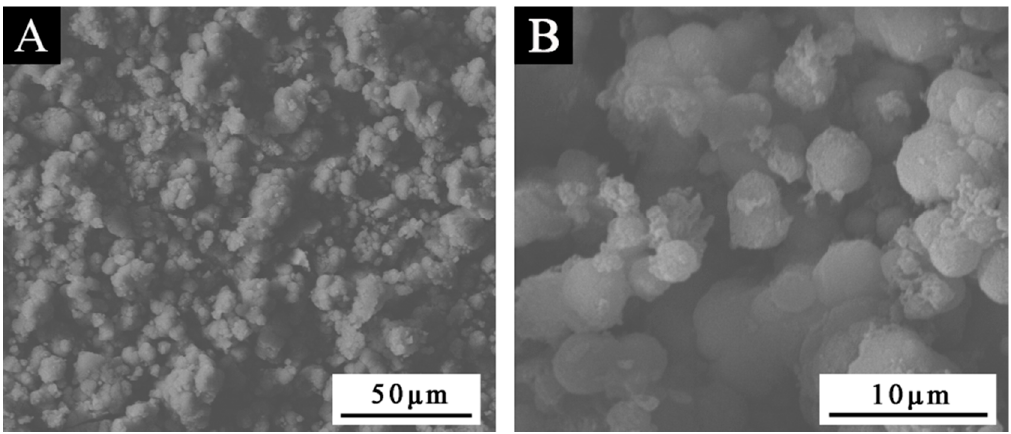
Figure 2. SEM of UF with waterborne emulsion microcapsules: ( A ) low and ( B ) high magnification.